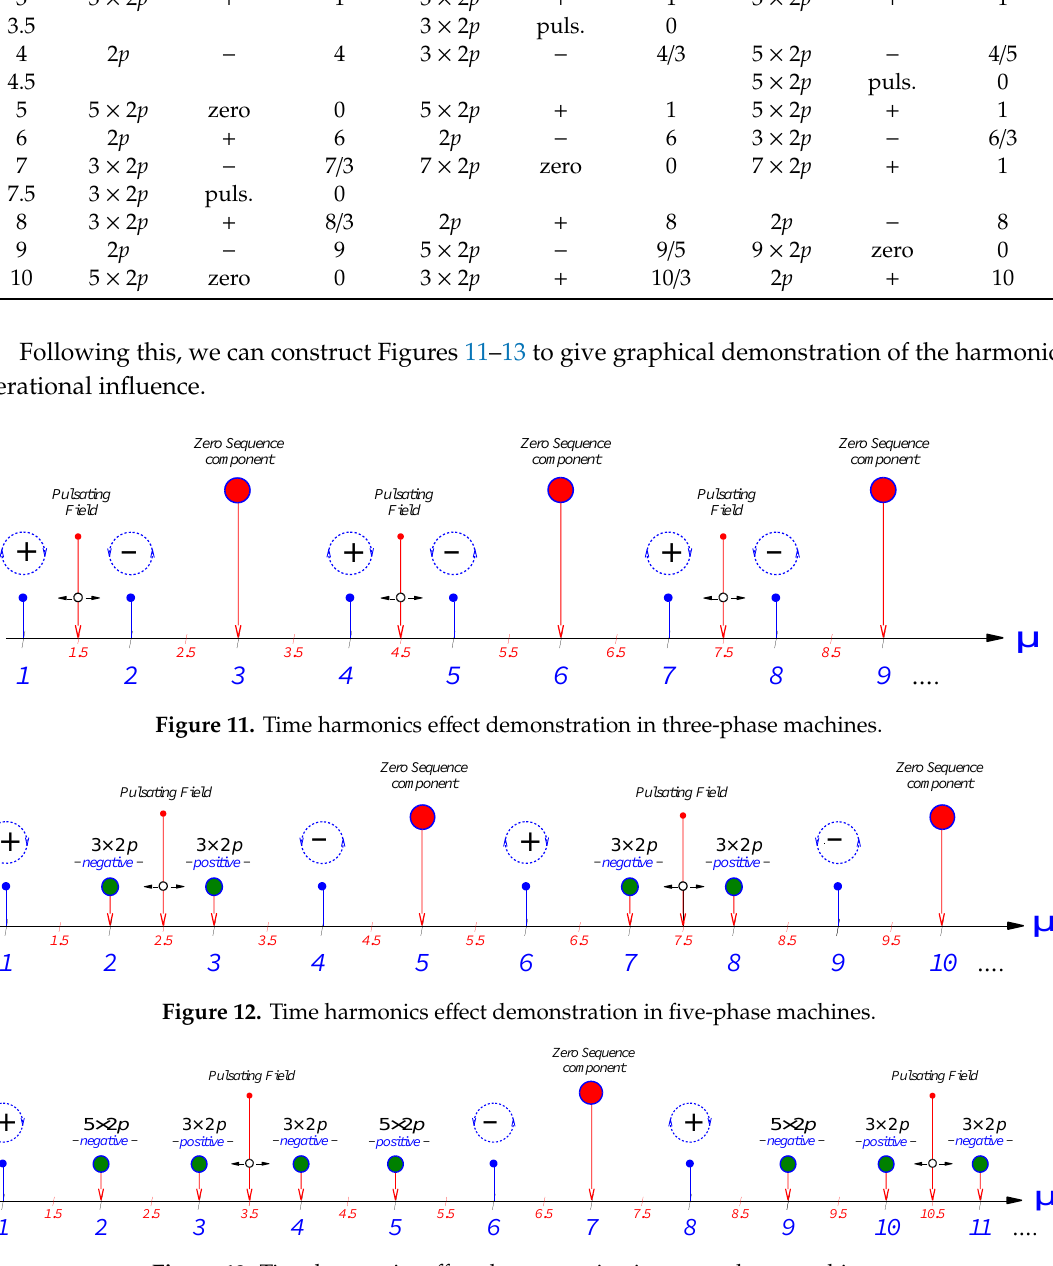
Figure 13. Time harmonics effect demonstration in seven-phase machines. Table 1. Time harmonics effect overview.